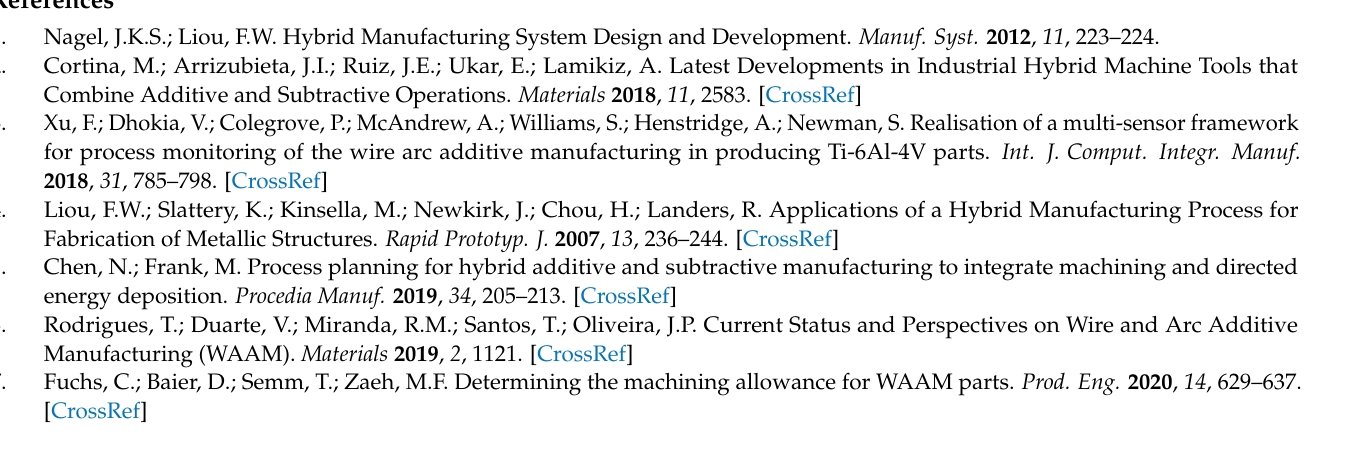
Table S3: Probe_Data_10pts_SmallFront, Table S4: Process Time Data, MATLAB Script: Adaptive